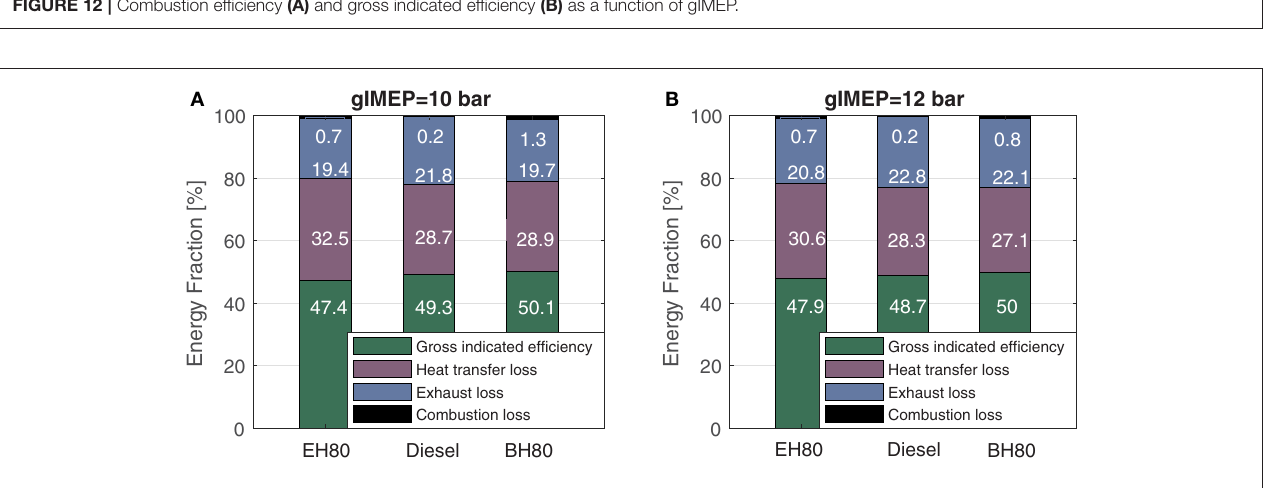
FIGURE 12 | Combustion efficiency (A) and gross indicated efficiency (B) as a function of gIMEP.